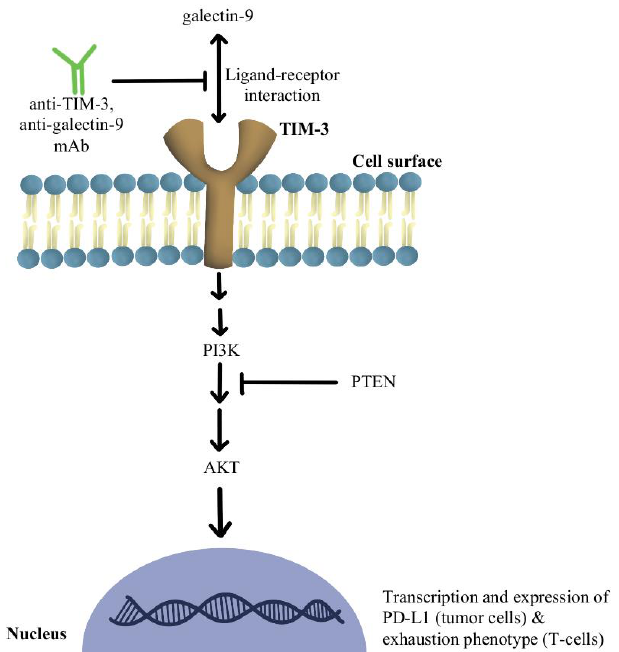
Figure 4. Diagram of TIM-3 pathway modulation (NCT04666688) [79 – 84]. Illustrated by Kaitlyn Mi of The Dartmouth Institute.